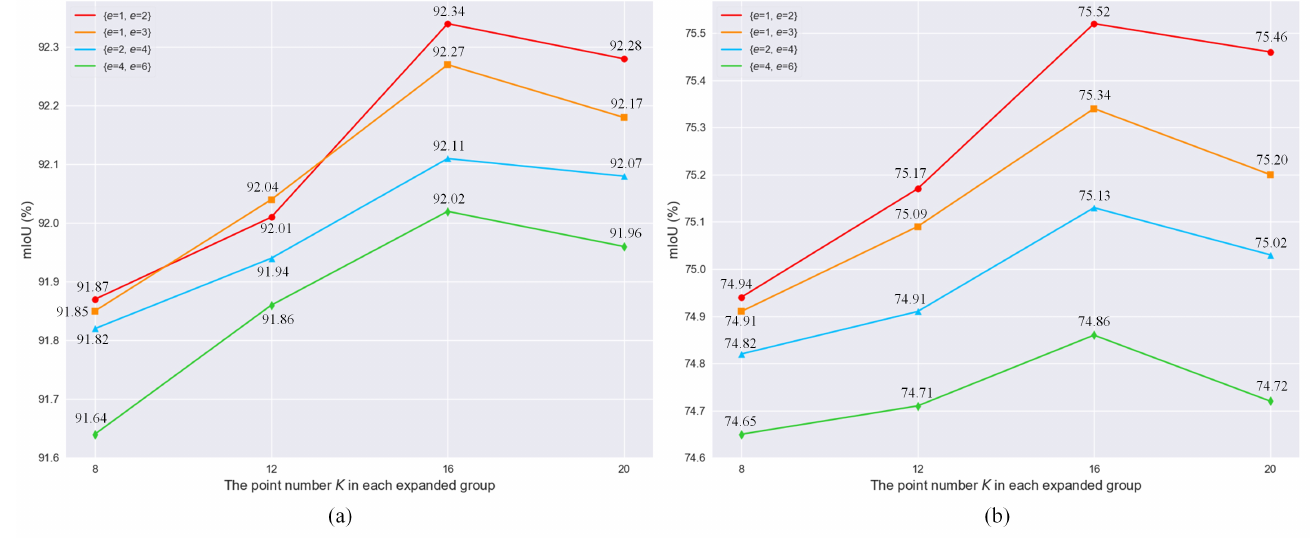
Figure 5. Classification performance varying with different parameter settings for the PEG unit. Accuracy variations of PEMCNet along with changing K and different expansion rates in terms of mIoU score on US3D dataset ( a ), PEMCNet on Semantic3D dataset ( b